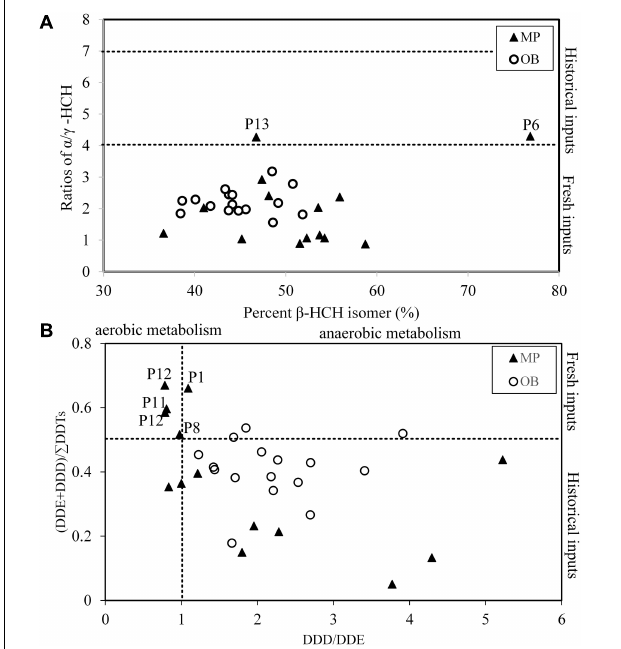
FIGURE 7 | Cross plots for the isomeric ratios of: (A) β -HCH percentage vs. (B) α / γ -HCH and DDD/DDE vs. (DDE + DDD)/ (cid:54) DDTs in different samples from Qingduizi